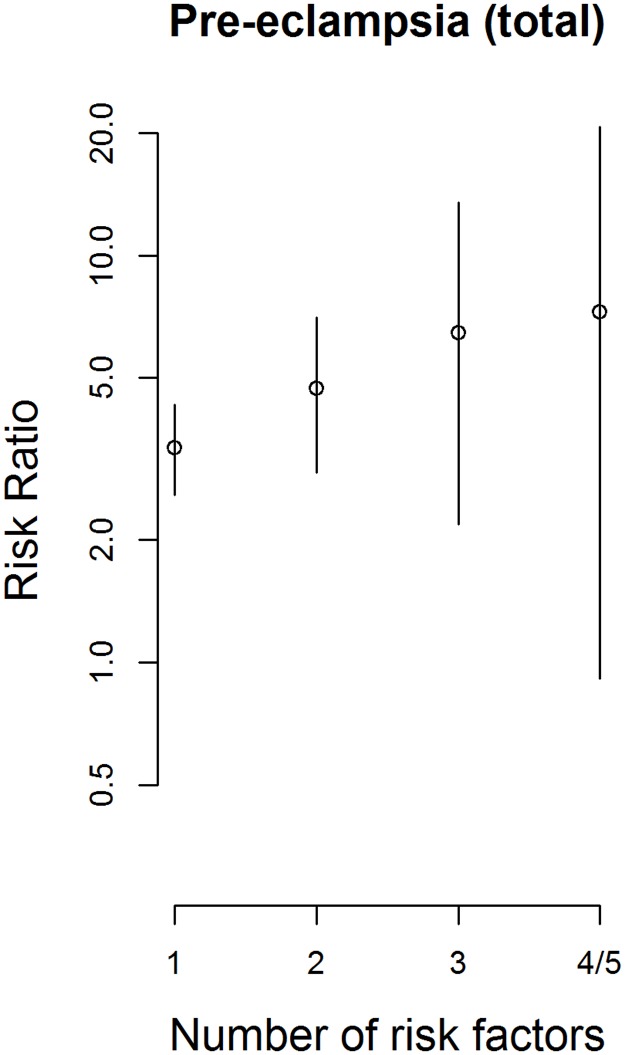
Risk ratio grows exponentially (linearly on the logarithmic scale) as the number of risk factors increases.The increase is significant when the risk of preeclampsia is predicted by the number of risk factors using logistic regression (Preeclampsia (total)(n = 86), p = 0.0181, b = 0.3429)